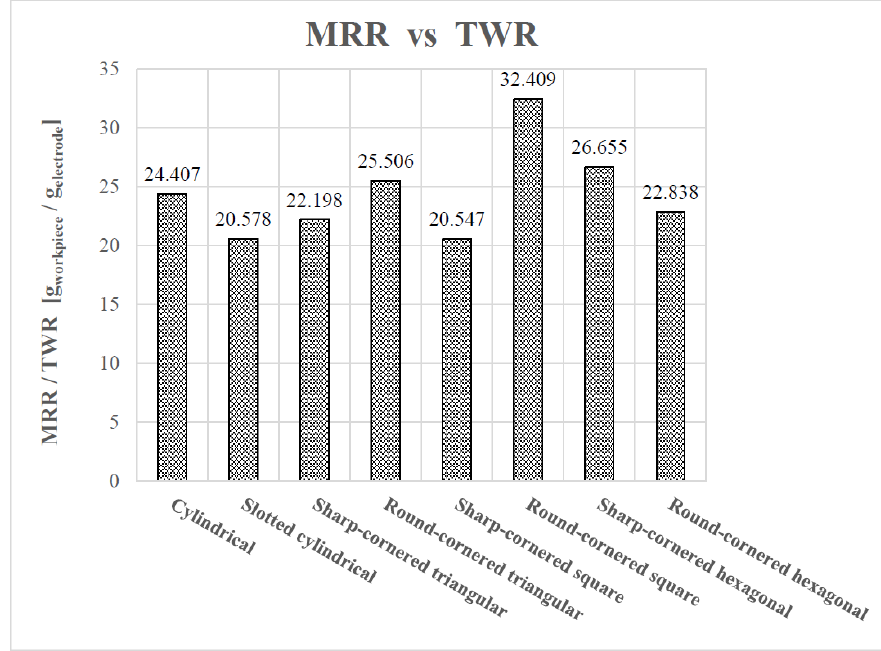
Figure 14. The ratio of the MRR to the TWR.